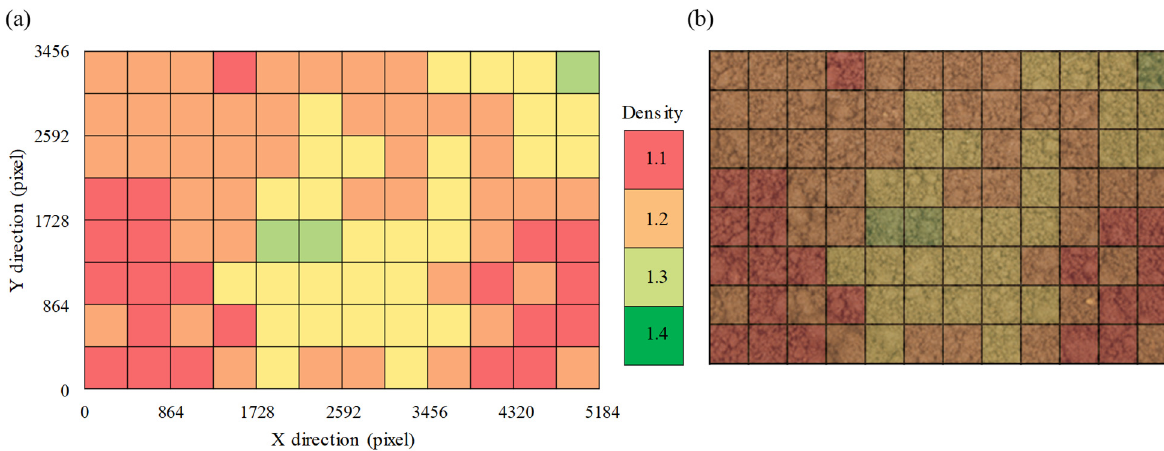
Figure 11. Example of soil dry density prediction by the convolutional neural network model. ( a ) Classification result with a resolution of 432 × 432 segmented images.; ( b ) original image overlaid with classification result.